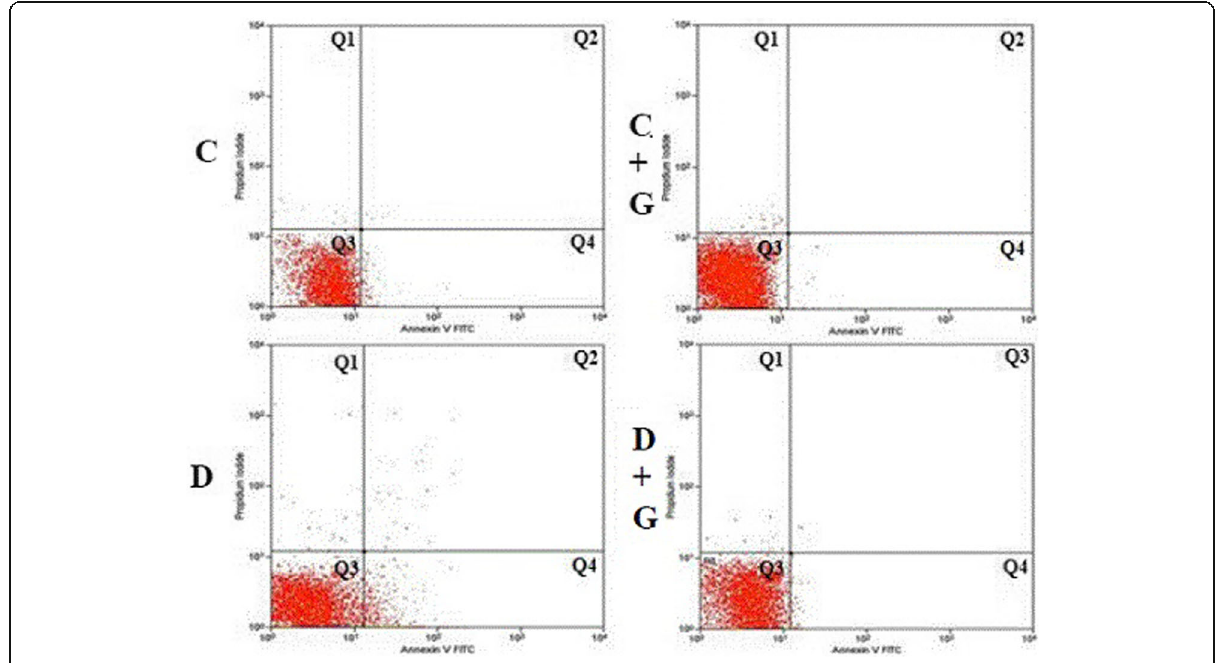
Fig. 5 The two-dimensional histogram of apoptotic and viable lymphocytes distribution in DotPlot mode. On the horizontal axis - the intensity of annexin V - FITC fluorescence, the vertical axis - the intensity of PI fluorescence. Q3 (annexin V − / PI − ) - viable cells; Q4 (annexin V + /PI − ) - cells with features of early apoptosis; Q2 (annexin V + /PI + ) - cells with features of late apoptosis; Q1 (annexin V − /PI + ) - cells with features of